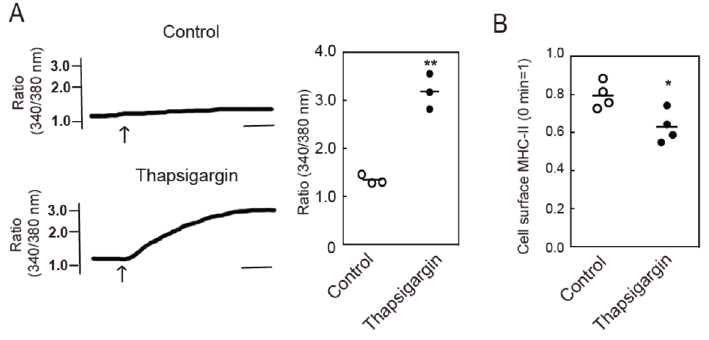
Figure 2. Intracellular Ca 2+ mobilization induces endocytosis of MHC-II. ( A ) BMDCs were stimulated with or without thapsigargin and cytosolic Ca 2+ mobilization was detected using Fura-2/AM. Bars = 1 min. Relative changes in the cytosolic Ca 2+ concentrations are expressed as the ratio of fluorescence intensity at 340/380 nm. ( B ) BMDCs were incubated with an anti-MHC-II antibody for 30 min at 4 °C. The cells were washed and stimulated with thapsigargin for 30 min at 37 °C. The remaining cell surface anti-MHC-II antibody was detected using a PE-labeled anti-mouse IgG antibody. Values of * p < 0.05, ** p < 0.01 are regarded as significant.